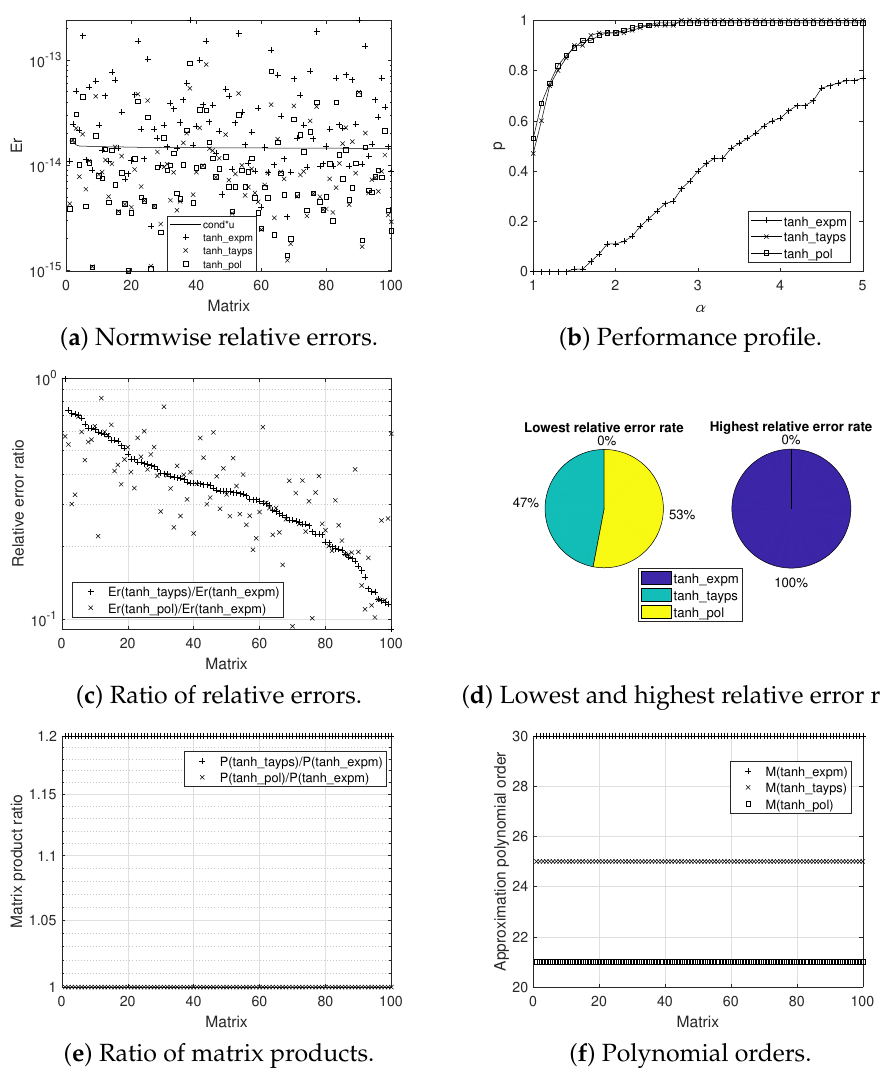
Figure 2. Experimental results for Test